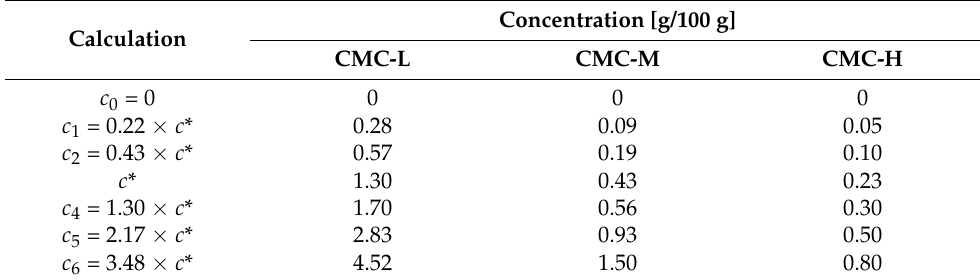
Concentration [g/100